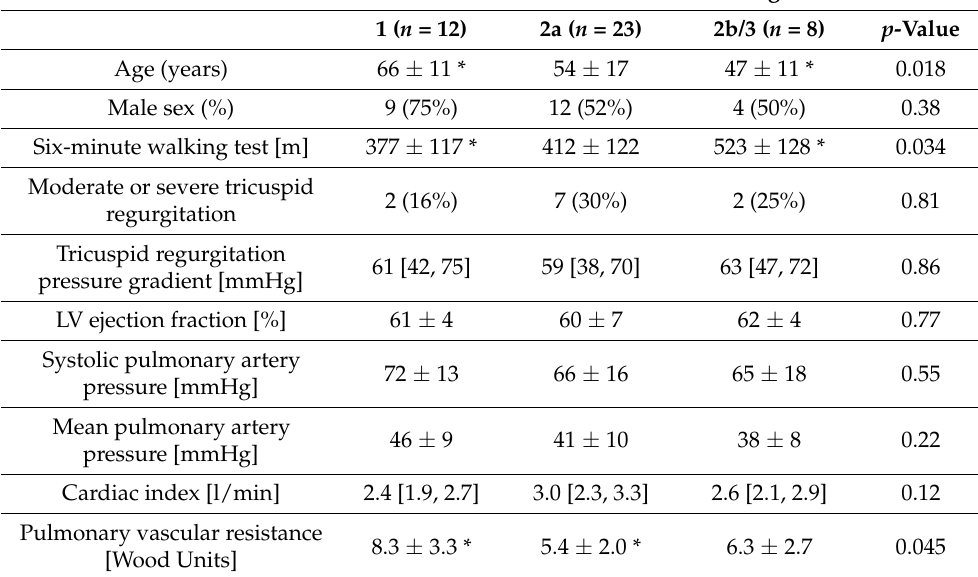
Table 3. Baseline hemodynamic parameters according to CT classification of thromboembolic level of disease.